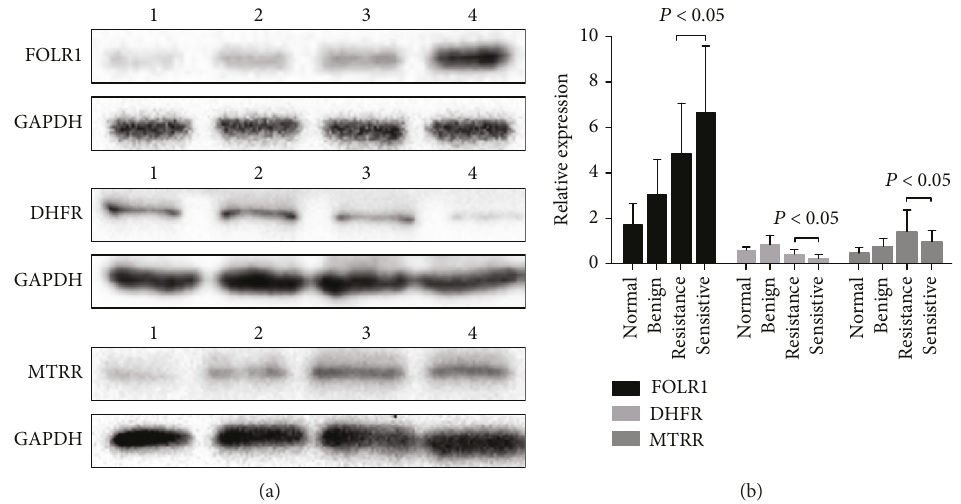
Figure 1: (a) Western blot assay of FOLR, DHFR, and MTRR expression in di ff erent ovarian tissues. Lane 1: normal ovarian tissues; lane 2: benign ovarian tumor; lane 3: platinum-resistant OC; and lane 4: platinum-sensitive OC. (b) Quantitative analysis of FOLR, DHFR, and MTRR expression in normal ovarian tissues and OC. FOLR, DHFR, and MTRR expression in Western blot assay is expressed as the ratio of OD of FOLR, DHFR, and MTRR to that of GAPDH. Data are expressed as means ± standard error